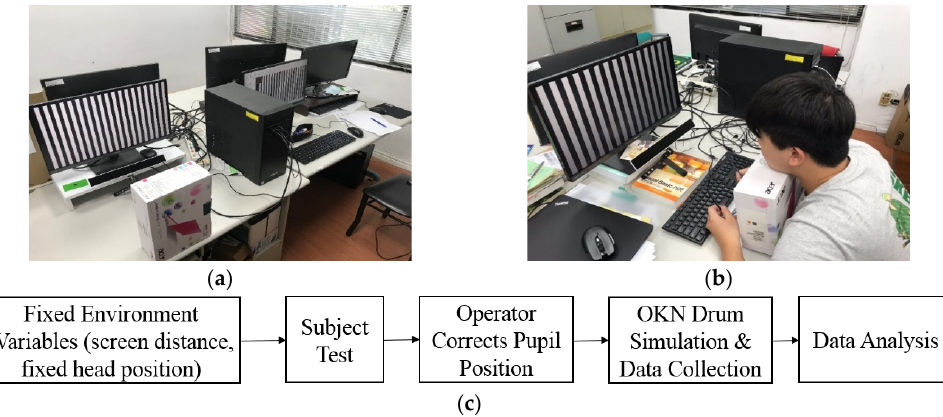
Figure 1. ( a ) Optokinetic nystagmus (OKN) data collection environment controlled by dual screens; ( b ) OKN detection is started after the head is fixed; ( c ) flowchart of experimental data collection.